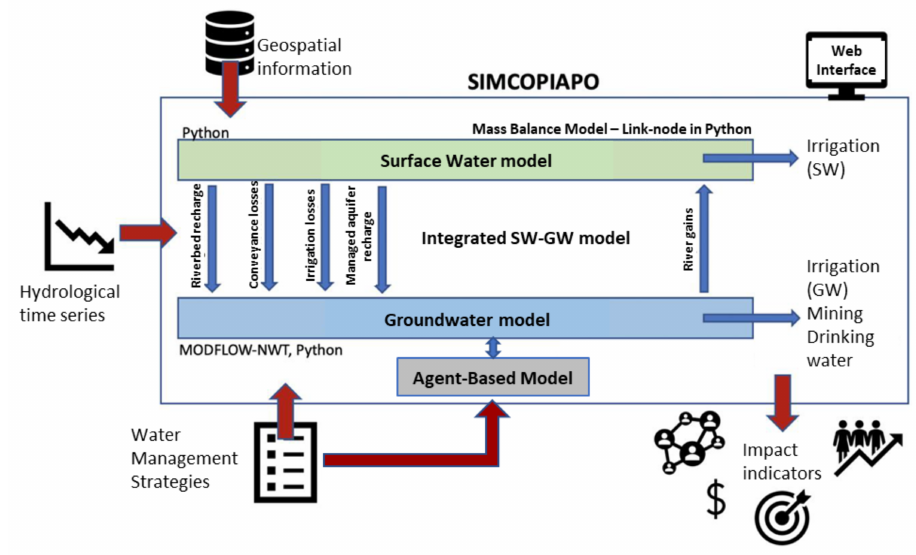
Figure 3. SimCopiapo digital platform and interactions of the integrated surface water and ground- water models and different modules and platform